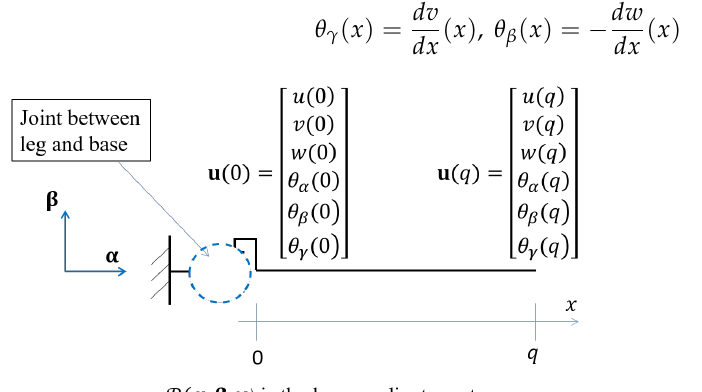
Figure 4. Local leg model and displacement